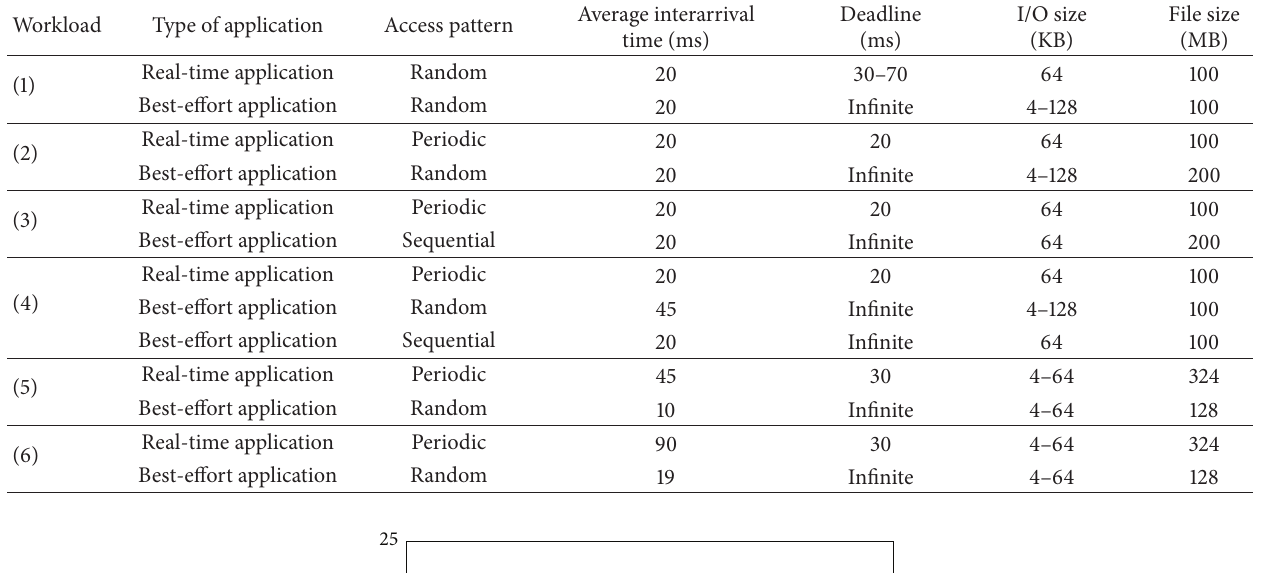
Table 2: Summary of workloads used in the experiments.